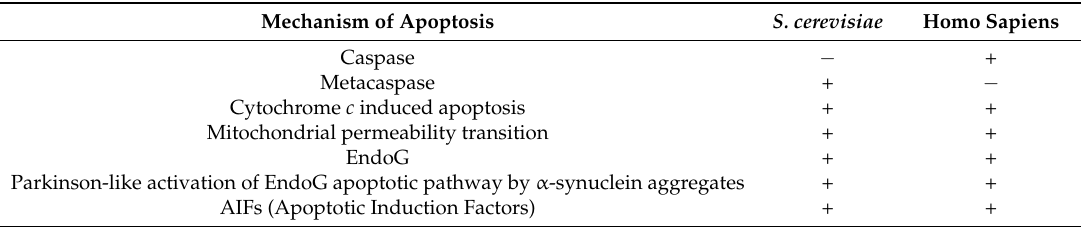
Table 1. Human and yeast apoptosis mechanisms. The table indicates that the majority of these apoptotic traits appeared before human/fungi diversification (probably even before the origin of eukaryotes). Mechanism of